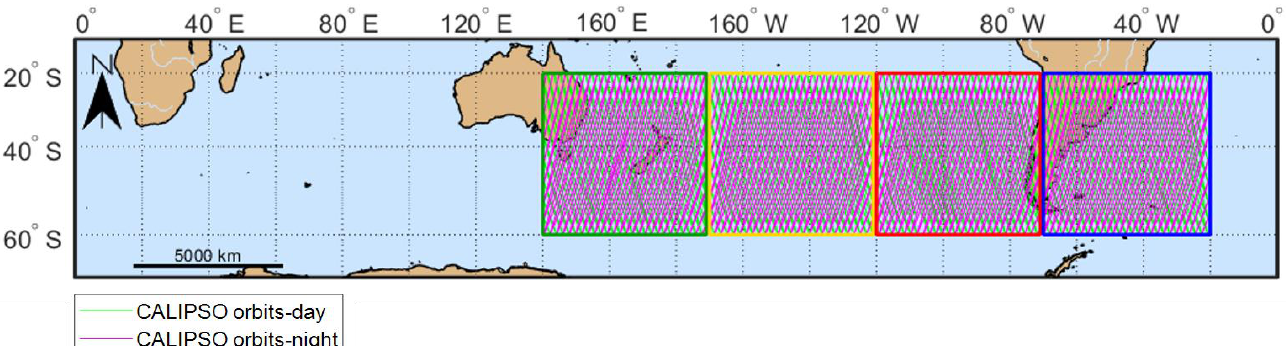
Figure 3. CALIPSO day- and night-time orbits per region of study, for the time period of 25